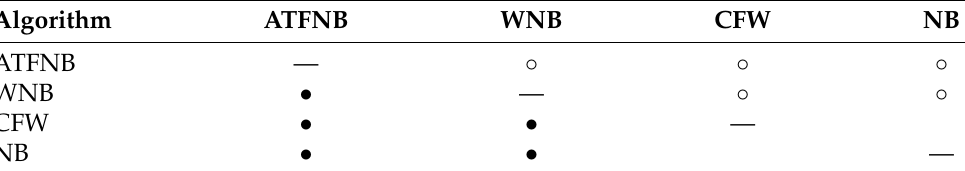
Table 8. Summary of the Wilcoxon test with regard to ATFNB on UCI datasets.